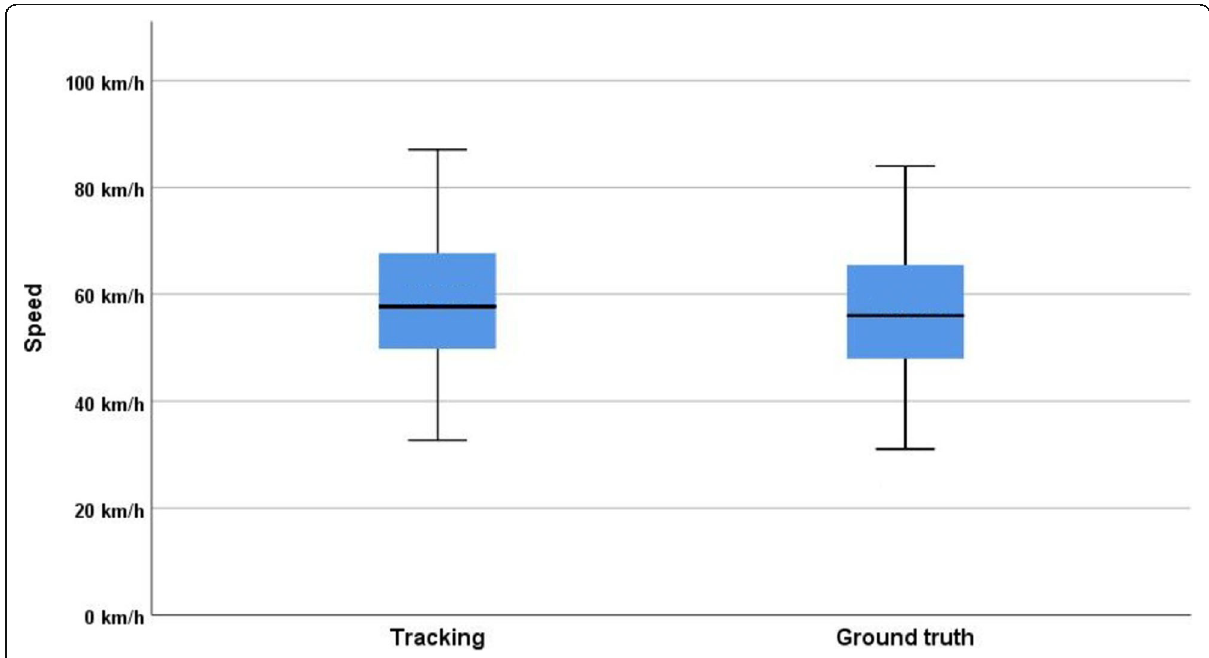
Fig. 6 Boxplots of samples of tracking and ground truth